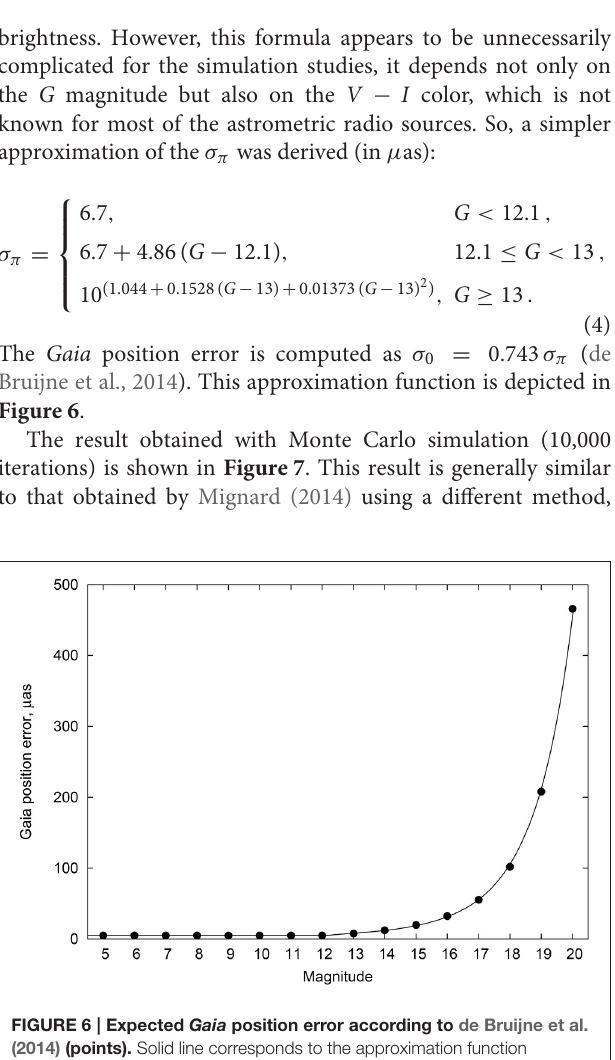
FIGURE 4 | Distribution of optical magnitudes in the gsf2015b catalog.